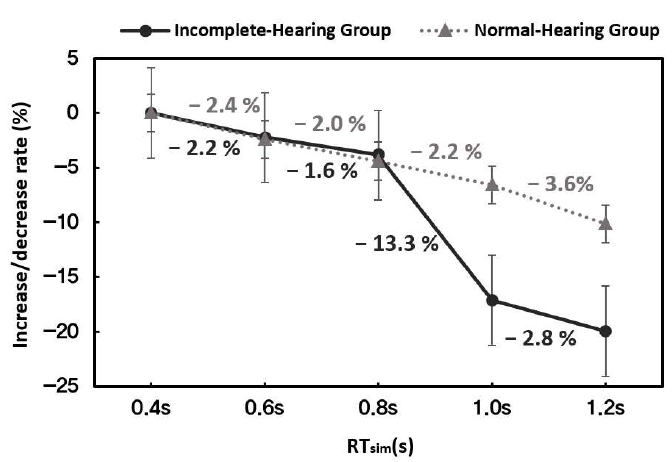
Figure 12. Rate of increase or decrease in the speech intelligibility test